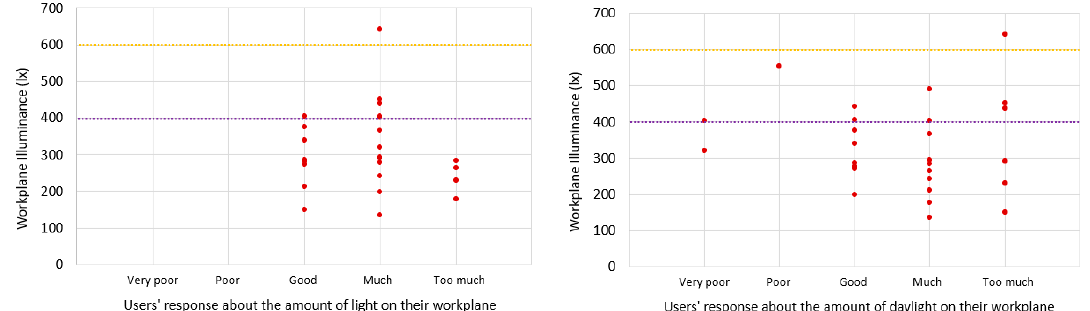
Figure 17. Occupants’ response for the amount of total lighting levels (left column) and the corresponding daylight on their working plane (right column) in relation to the measured illuminance (Building A: Upper part, Building B: Middle, Building C: Lower part).